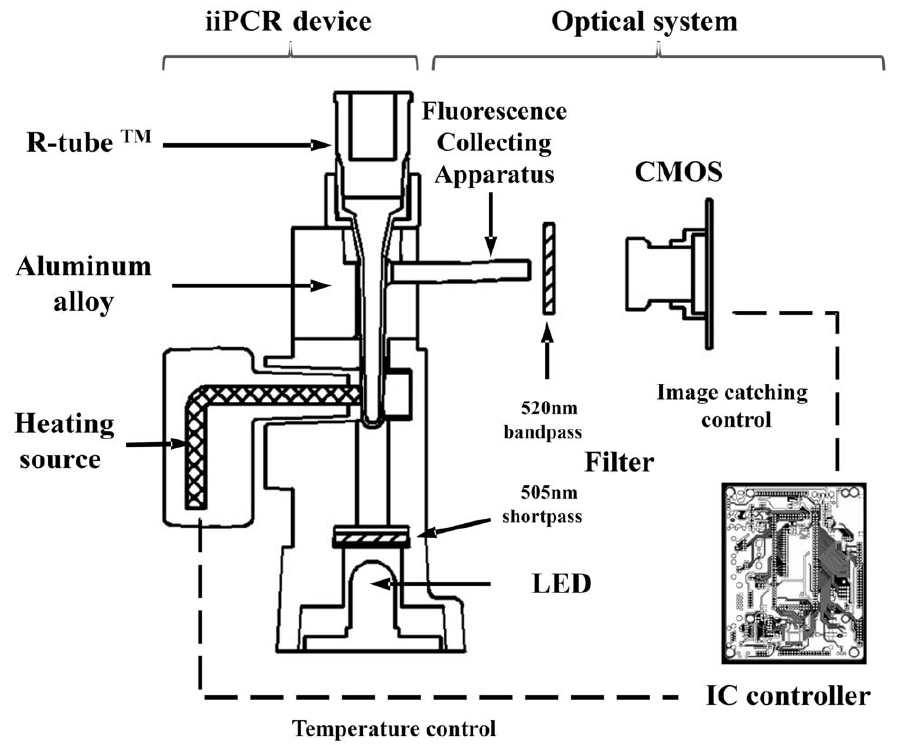
Figure 1. Integration of an optical detection module with the iiPCR module in the modified iiPCR device. The diagram depicts the iiPCR module and the optical detection module, which consists of an LED light source, a 505-nm short-pass filter, a 520-nm bandpass filter, fluorescence collecting apparatus, a CMOS, and an IC controller. The dotted lines indicate that the IC controller modulates the heating source of R-tubes to provide appropriate reaction temperatures and directs CMOS to collect and record light signals before and after a reaction.